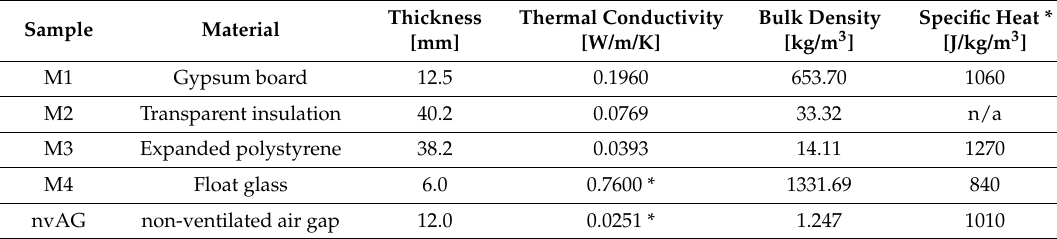
Table 2. Table of measured materials.